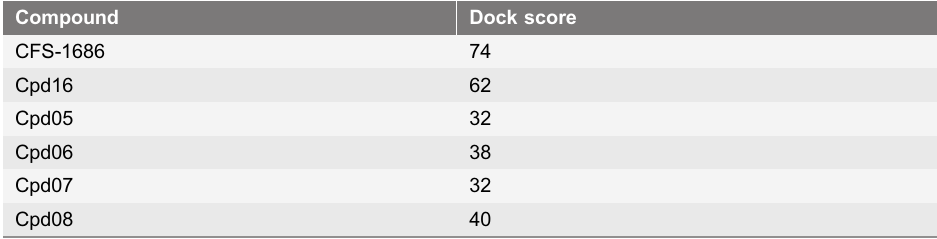
Table 1. Docking score of CFS-1686 in comparison with five studied compounds